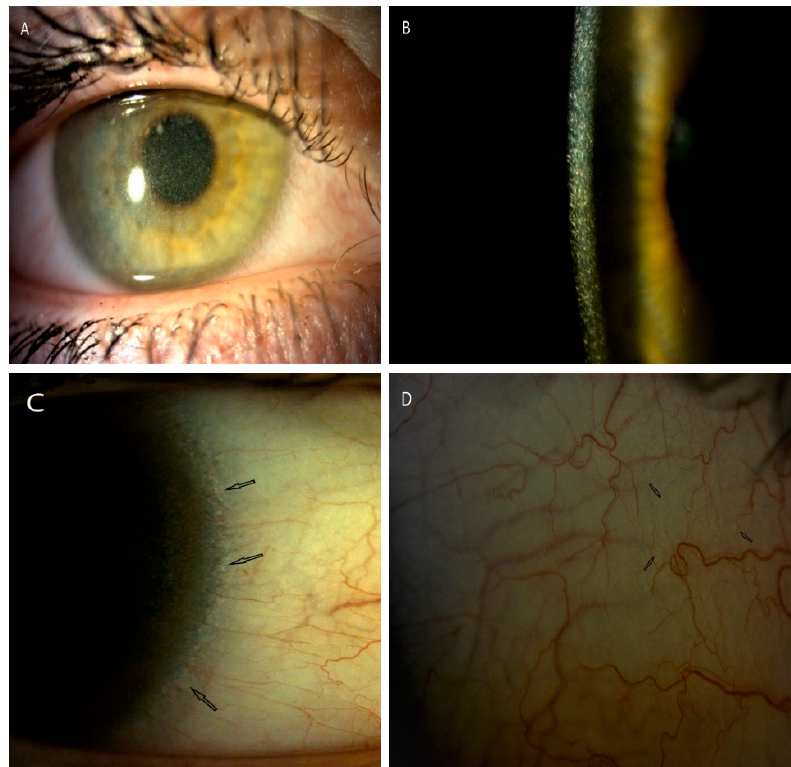
Figure 1. Corneal slit-lamp photographs (10 – 25 × ) of a patient (P5) with juvenile form of cystinosis. ( A ) View of whole cornea with crystal deposits in wide slit-lamp beam. ( B ) A large number of cystine deposits extending from the center to the periphery of the cornea in high magnification slit beam (25 × ). ( C ) Arrows show cystine deposits in corneal limbus and in conjunctiva ( D ).